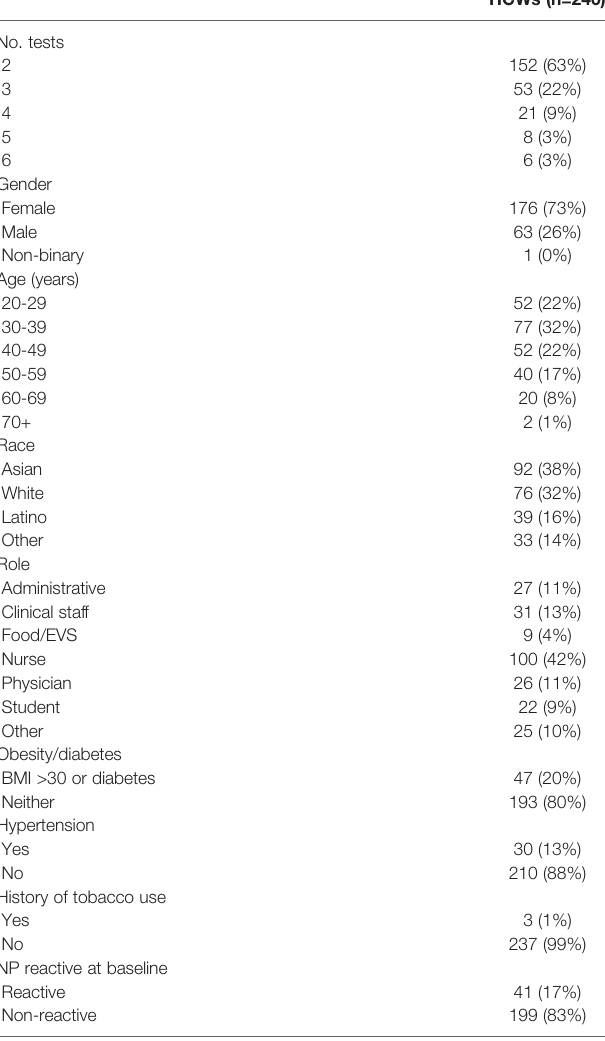
TABLE 1 | Characteristics of study participants compared between all study participants and the longitudinal cohort who provided data at multiple time points post